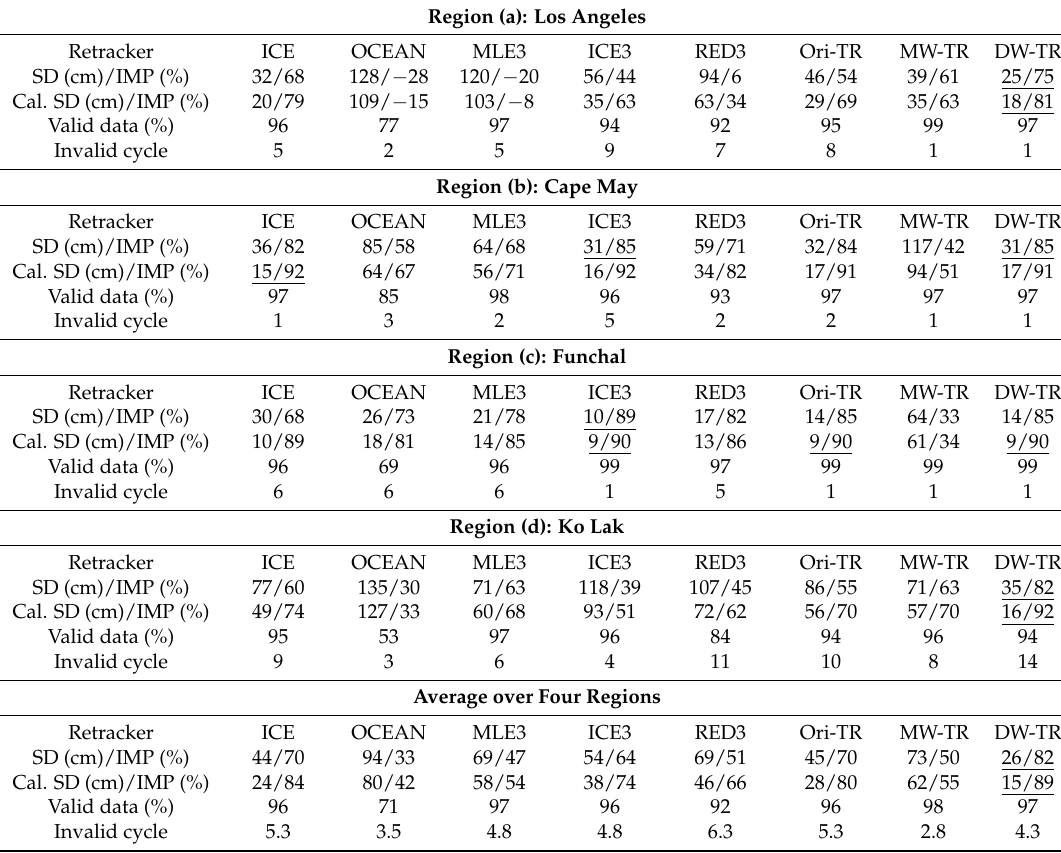
Table 3. Mean standard deviation of the difference between retracked along-track SSHs and geoid within 10 km offshore in four study